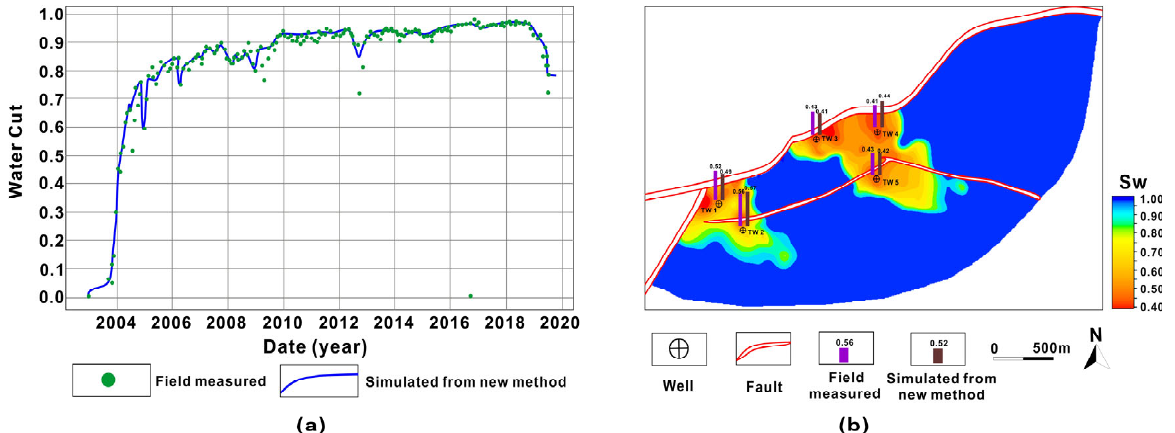
Figure 14. ( a ) Fitting diagram of water saturation in study area. ( b ) The water saturation contour map of the target layer in the study area shows the relationship between the predicted water cut and the measured water cut of the verification